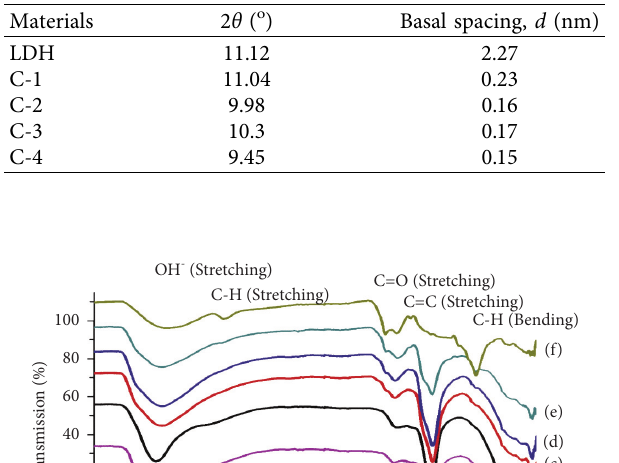
Figure 2: X-ray diffractogram of LDH (a), 0.5 HC:LDH (b), 1.0 HC:LDH (c), 1.5 HC:LDH (d), 2.0 HC:LDH (e), and HC Table 1: Impact of HC content on basal spacing and shift in 2 θ value.